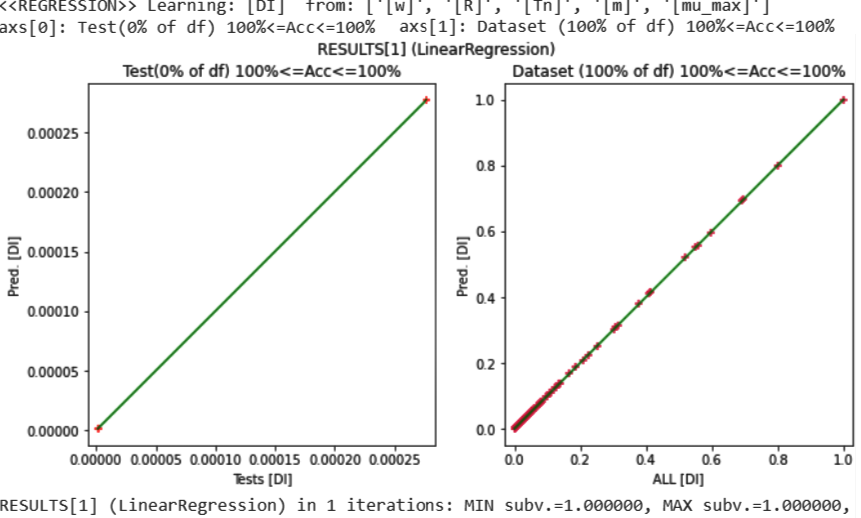
Figure 6. Relationships of the predicted [ DI ] with the tested [ DI ] and all [ DI ]. When one keeps decreasing the training size and using k-fold cross-validation for different values of k > 2, one can still achieve a 100% accuracy for any training size that is at least 0.171% of the whole 1170-row dataset. This latter percentage, 0.171%, gives two quantitatively different samples from the dataset with 1170 samples, which are geometrically enough to get a unique straight line in the 2D plane of actual-vs.- predicted [ DI ] (check the left part of Figure 6). As described, the relation between the [ DI ] and [ 𝜇 𝑚𝑎𝑥 ] values is linear. Linear regression is broadly applicable only if the solution is linear, which might not be the case in many other real-life scenarios. In learning [ DI ] from 𝜇 𝑚𝑎𝑥 (with or without other parameters), one obtains a 100% accuracy whether or not the data is normalized, and whether or not the whole dataset is used. This overfitting is always obtained, as a result of including [ 𝜇 𝑚𝑎𝑥 ] among the learning features. Normalization of data features is a process that is sometimes involved to ensure similar value ranges for input parameters of the model. In our case, this was not a major issue (note that although normalization was performed in our tests, it had no impact on the outcomes that are highlighted).